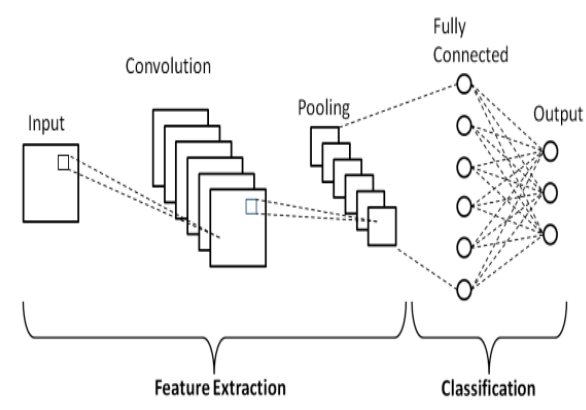
Figure 1. Convolution Neural Network (CNN)